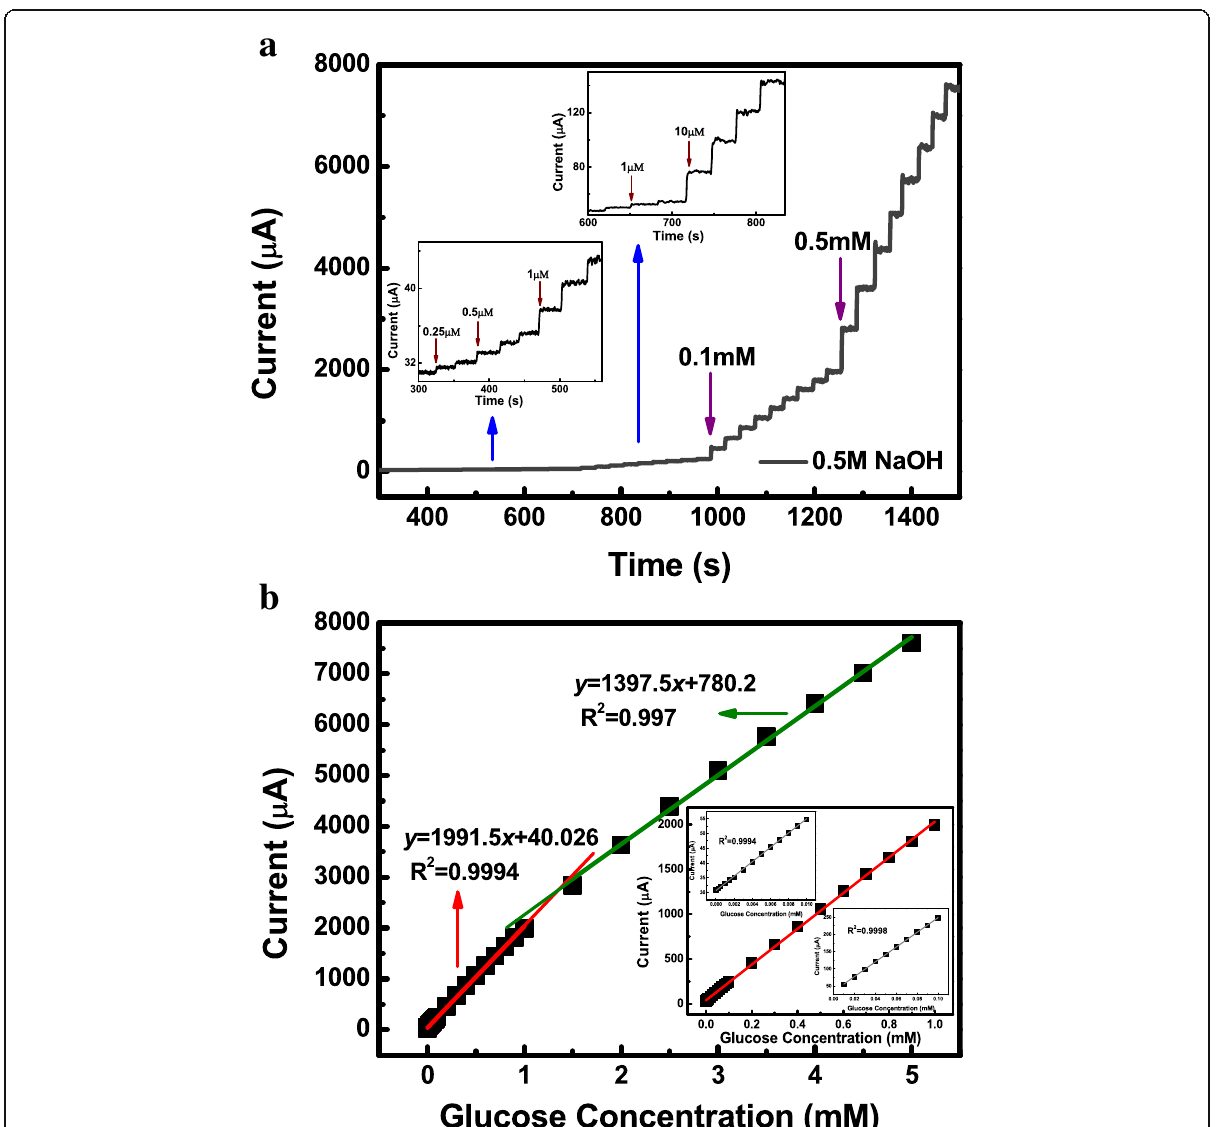
Fig. 4 Amperometric detection of glucose. Amperometric current-time (i-t) curve ( a ) and corresponding calibration curve ( b ) of the glucose oxidation on the Co-Ni hydroxide electrode acquired in 0.5 M